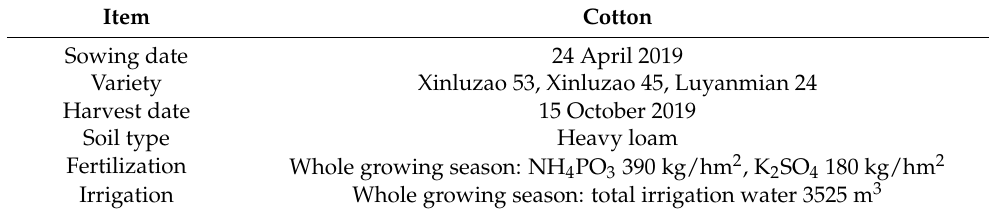
Table 1. Crop management